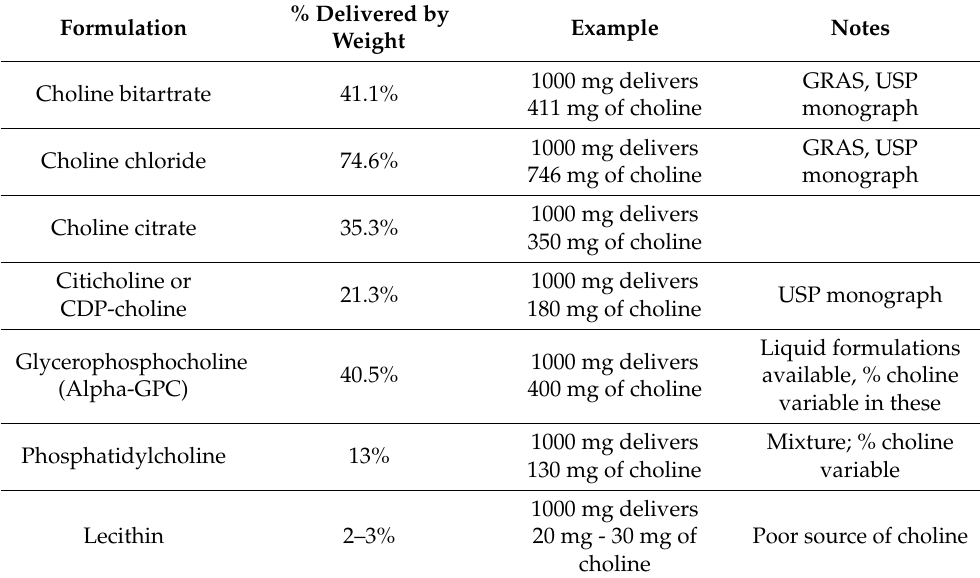
Table 4. Choline